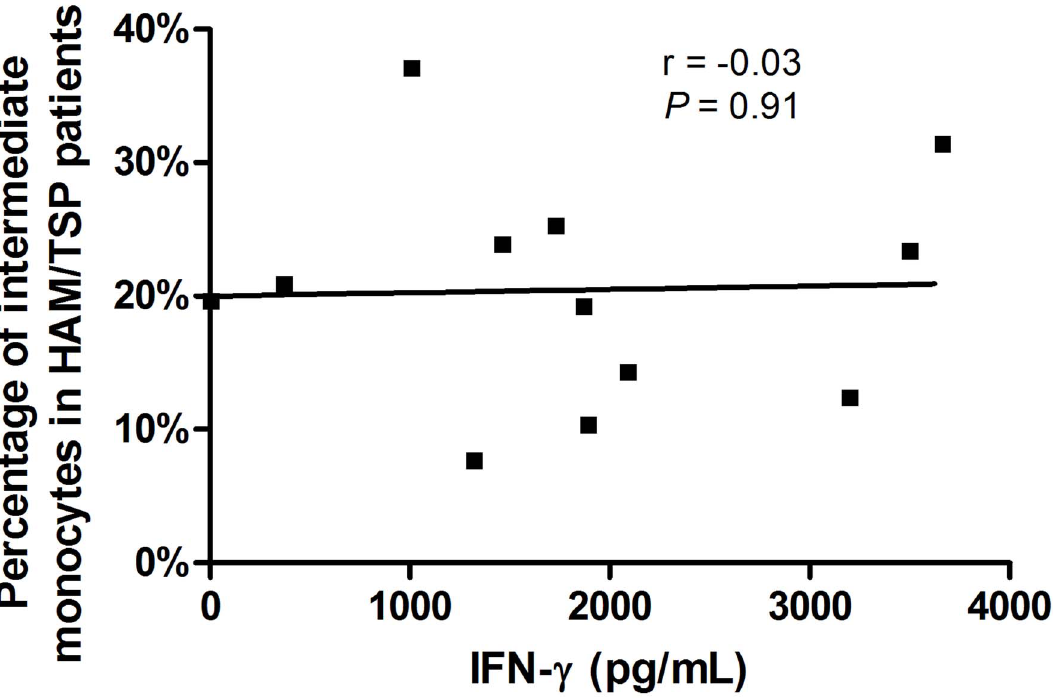
Fig. 2. Correlation between IFN- c produced by PBMCs and intermediate monocytes frequency from HAM/TSP patients. Correlation between IFN- c production by PBMCs and intermediate monocytes frequency from HAM/TSP patients (n=12). Spearman correlation and r significance test were used for statistical analyses ( P , 0.05).